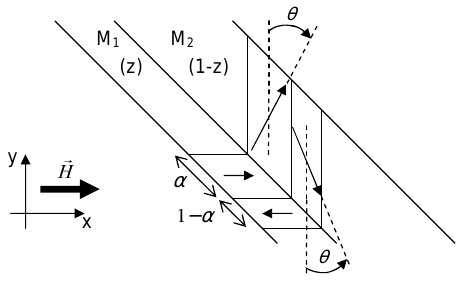
Figure 2: Representative Elementary Volume when the MSM sample is only composed of two martensite variants M 1 and M 2 ( z = z 1 and 1 − z = z 2